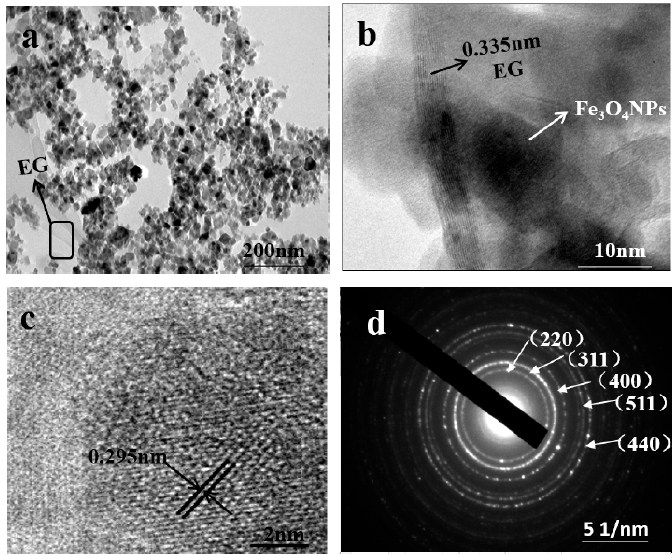
Figure 3. Transmission electron microscopy (TEM) images of EG / Fe 3 O 4 (S1) composite ( a ); High Resolution Transmission Electron Microscope (HRTEM) image ( b , c ) and Selected Area Electron Di ff raction (SAED) pattern ( d ) of EG / Fe 3 O 4 (S1)